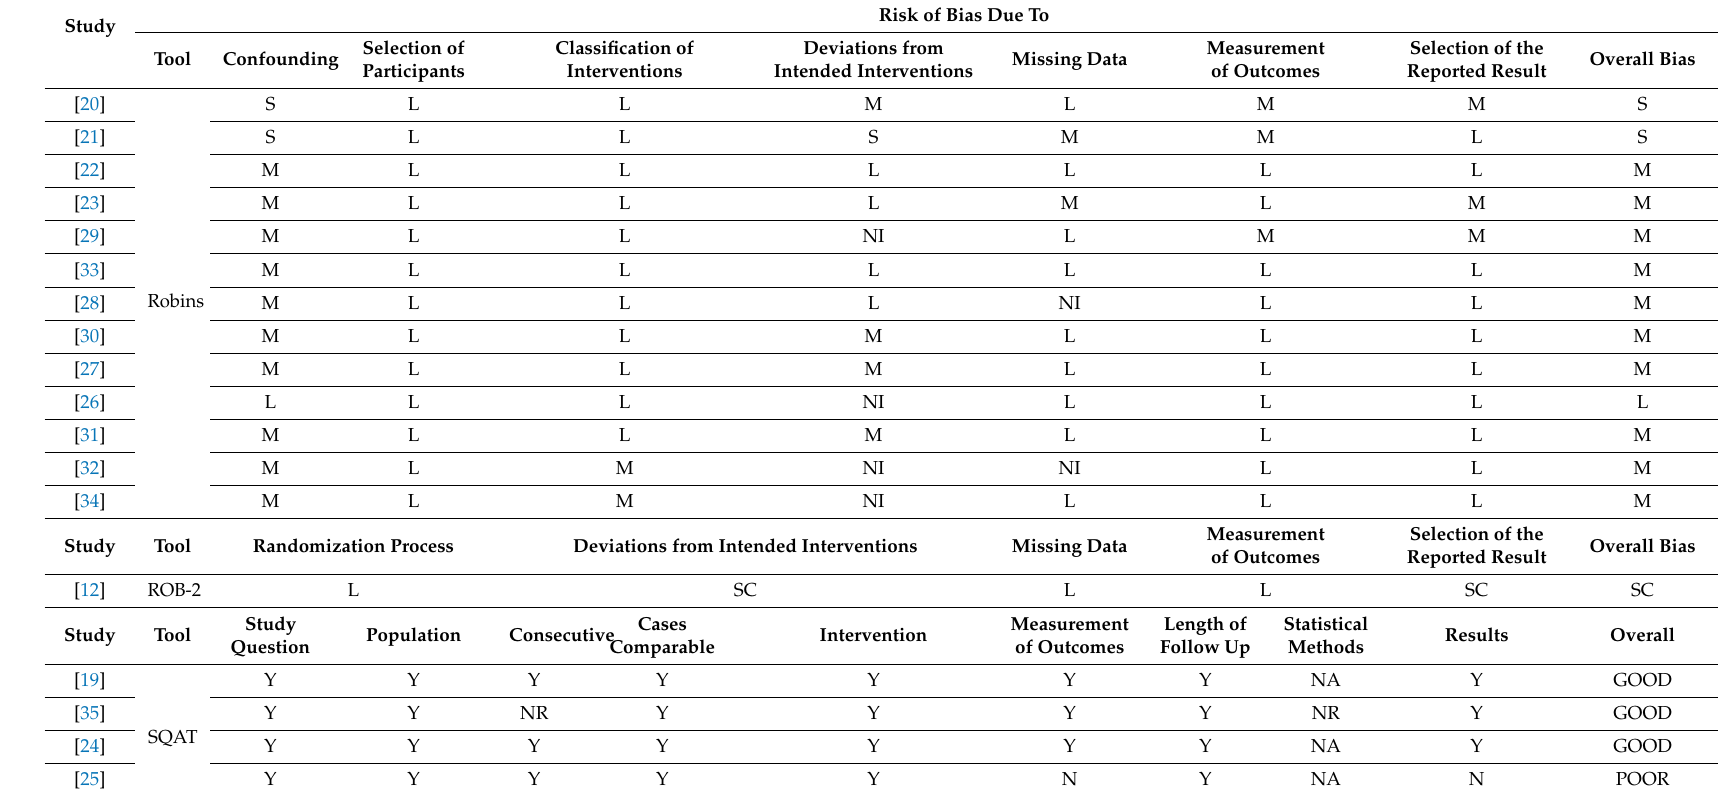
Table 2. Quality assessment of the